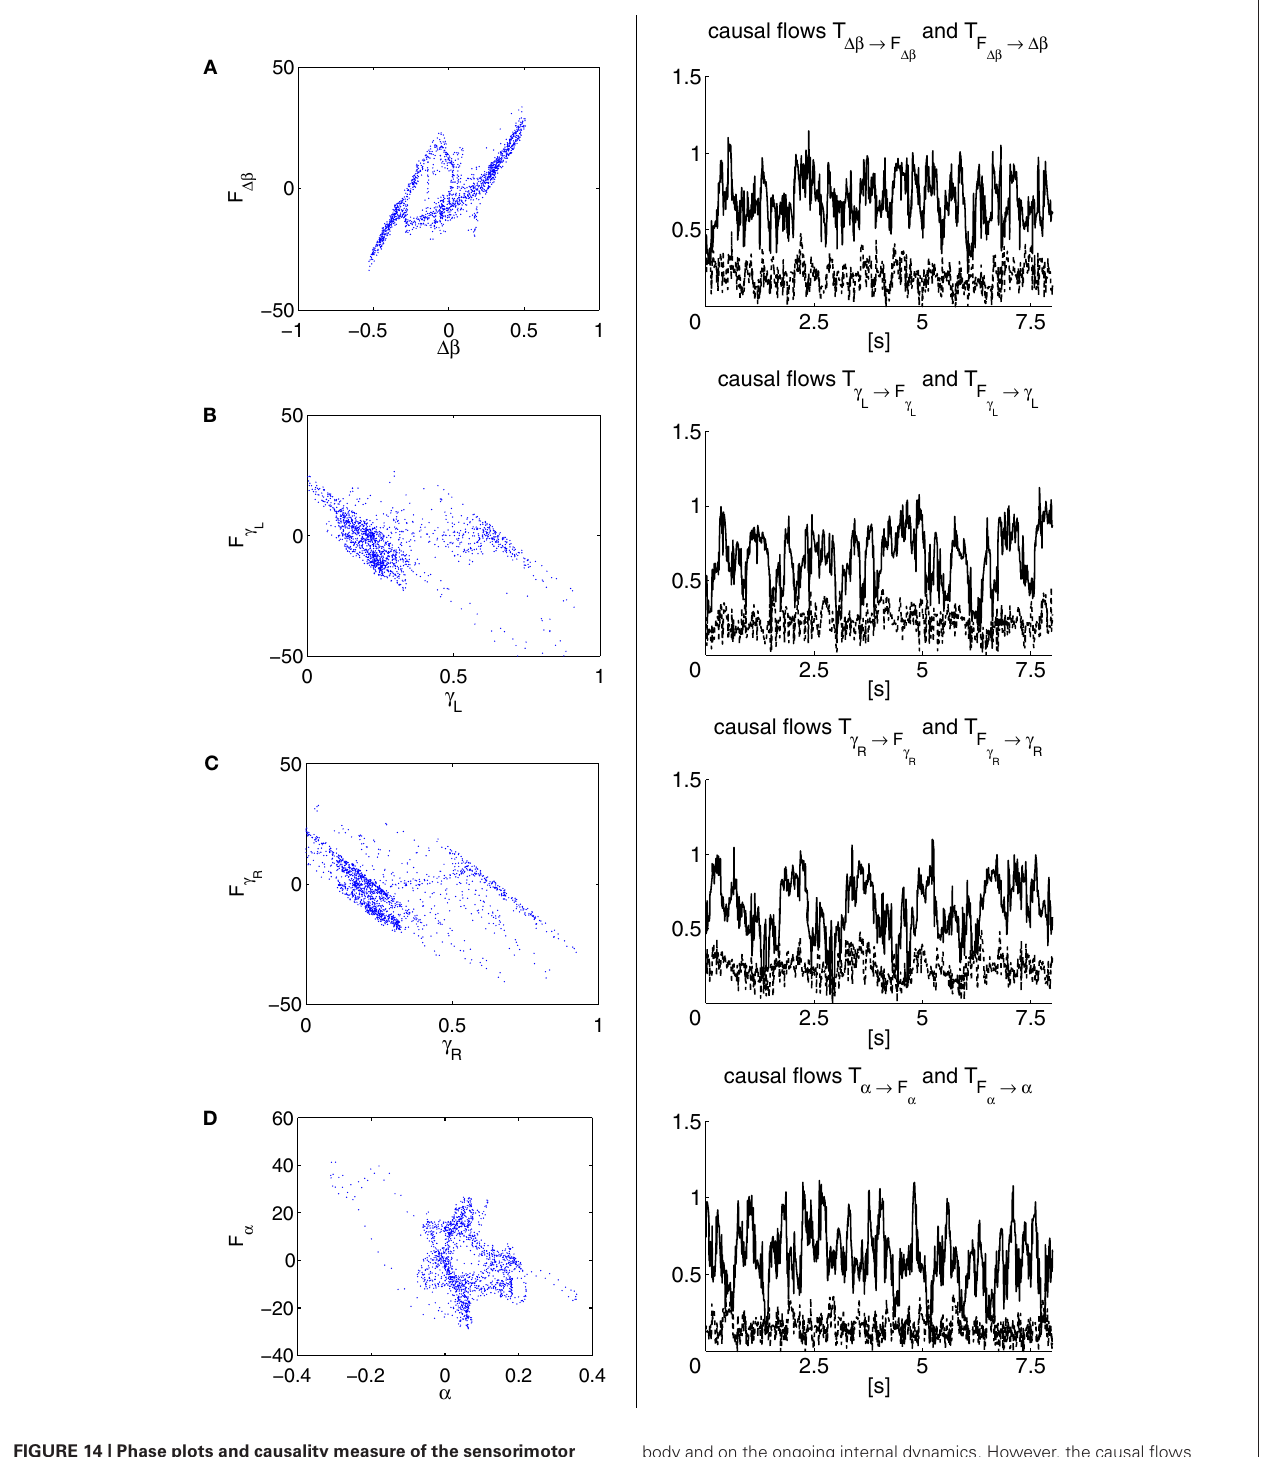
FIGURE 14 | Phase plots and causality measure of the sensorimotor body and on the ongoing internal dynamics. However, the causal fl ows information fl ow in all the joints during walking; resp. left and right between the two systems reveals that the body drives most of the time column. In the right, the causal fl ows from the body dynamics X to its controller F , Te , are drawn in plain lines. The causal fl ows from the X F X → X controller F to its sensory variable X , Te , are drawn in dashed lines. F X X → X During walking, the body and the controllers fl exibly entrain themselves dynamically. This coordination depends bothly on the current posture of the